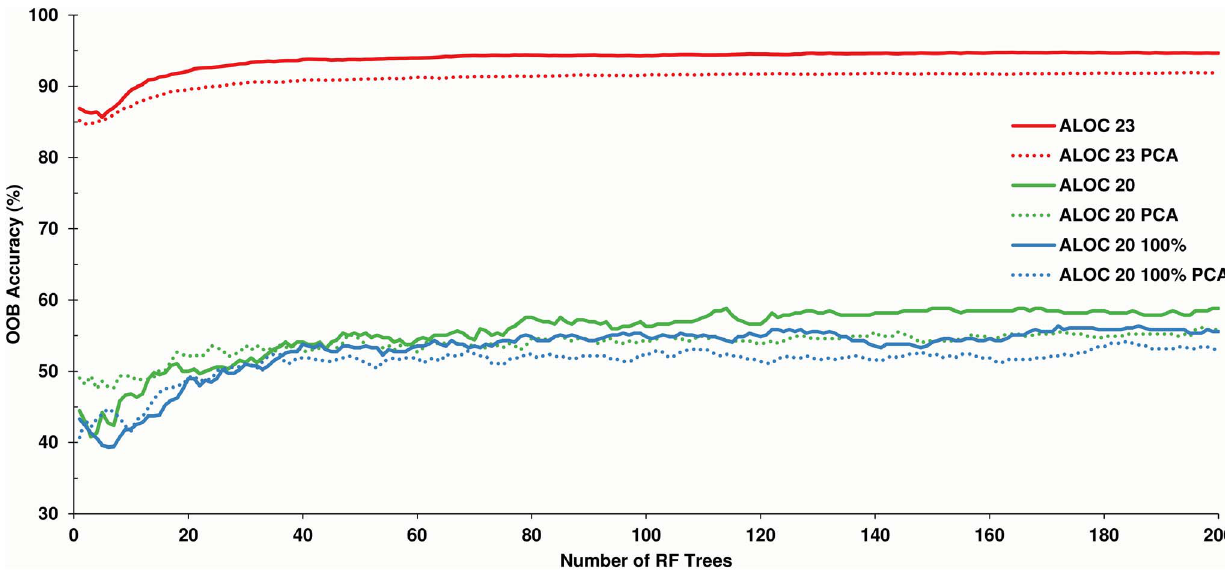
Figure 4. Out-Of-Bag (OOB) percent accuracies for the ALOC clusterings as classified by Random Forests. The 30-m ALOC 23 and ALOC 23 PCA models were significantly more accurate than the 10-km ALOC 20 classifications.